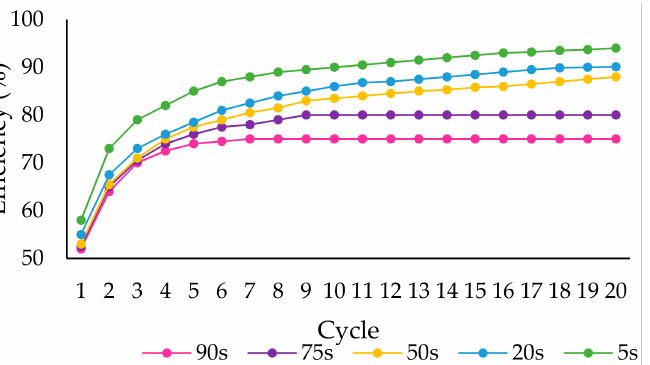
Figure 12. The efficiency values according to the number of cycles for spherical packed bed in decentralized heat recovery ventilation units